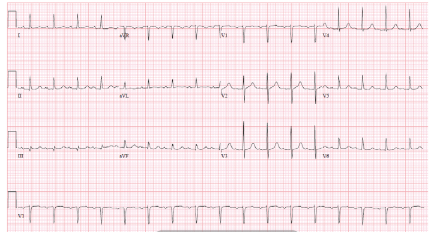
Figure 4: Resolution of ST elevation in inferolateral leads after surgical decompression (case 1).